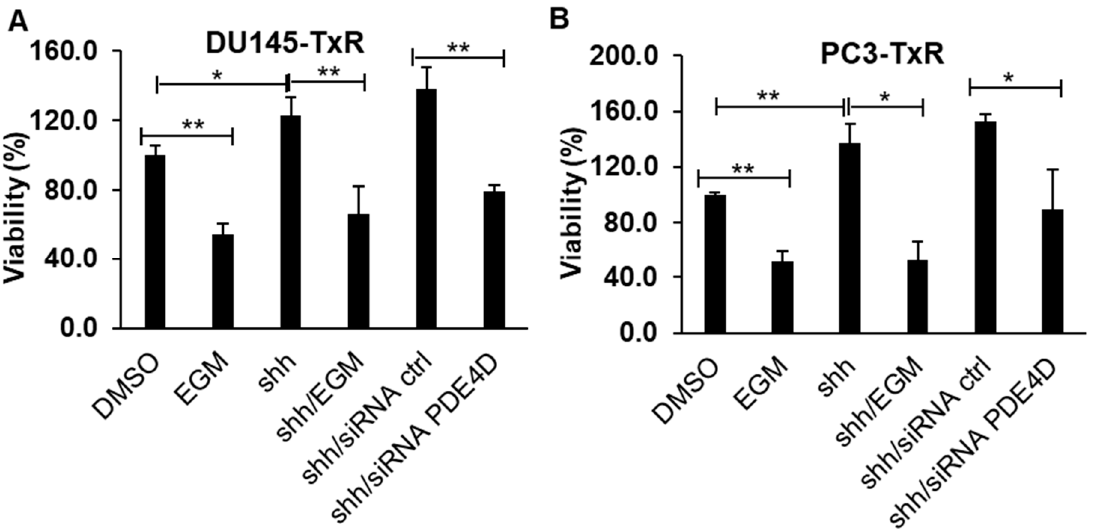
Figure 4. Eggmanone reduces the proliferation of chemo-resistant prostate cancer cells through sonic Hedgehog pathway. ( A ) The chemo-resistant prostate cancer DU145-TxR and ( B ) PC3-TxR cells were treated with DMSO vehicle, 3 µ M Eggmanone, 200 ng/mL sonic Hedgehog (shh) ligand, 200 ng/mL shh with 3 µ M Eggmanone (EGM), 200 ng/mL shh with siRNA control and 200 ng/mL shh with PDE4D knockdown with siRNA, respectively, for 72 h. The cell viability (%) was normalized with DMSO vehicle treated cells, and the result indicated that shh increases the chemo-resistant prostate cancer cell viability which is suppressed by PDE4D knockdown ( n = 3, * p < 0.05, ** p < 0.01).